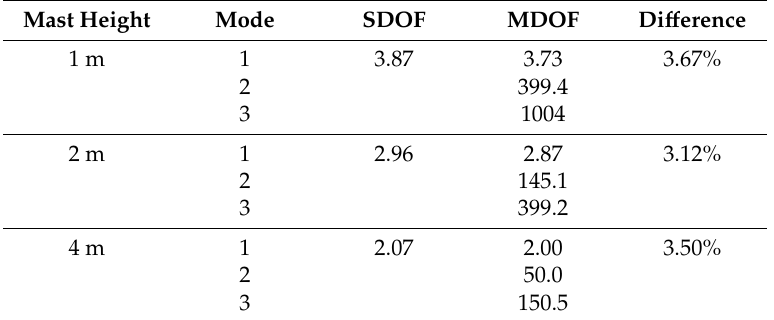
Table 6. First three natural frequencies of the SDOF and MDOF models of the H-type